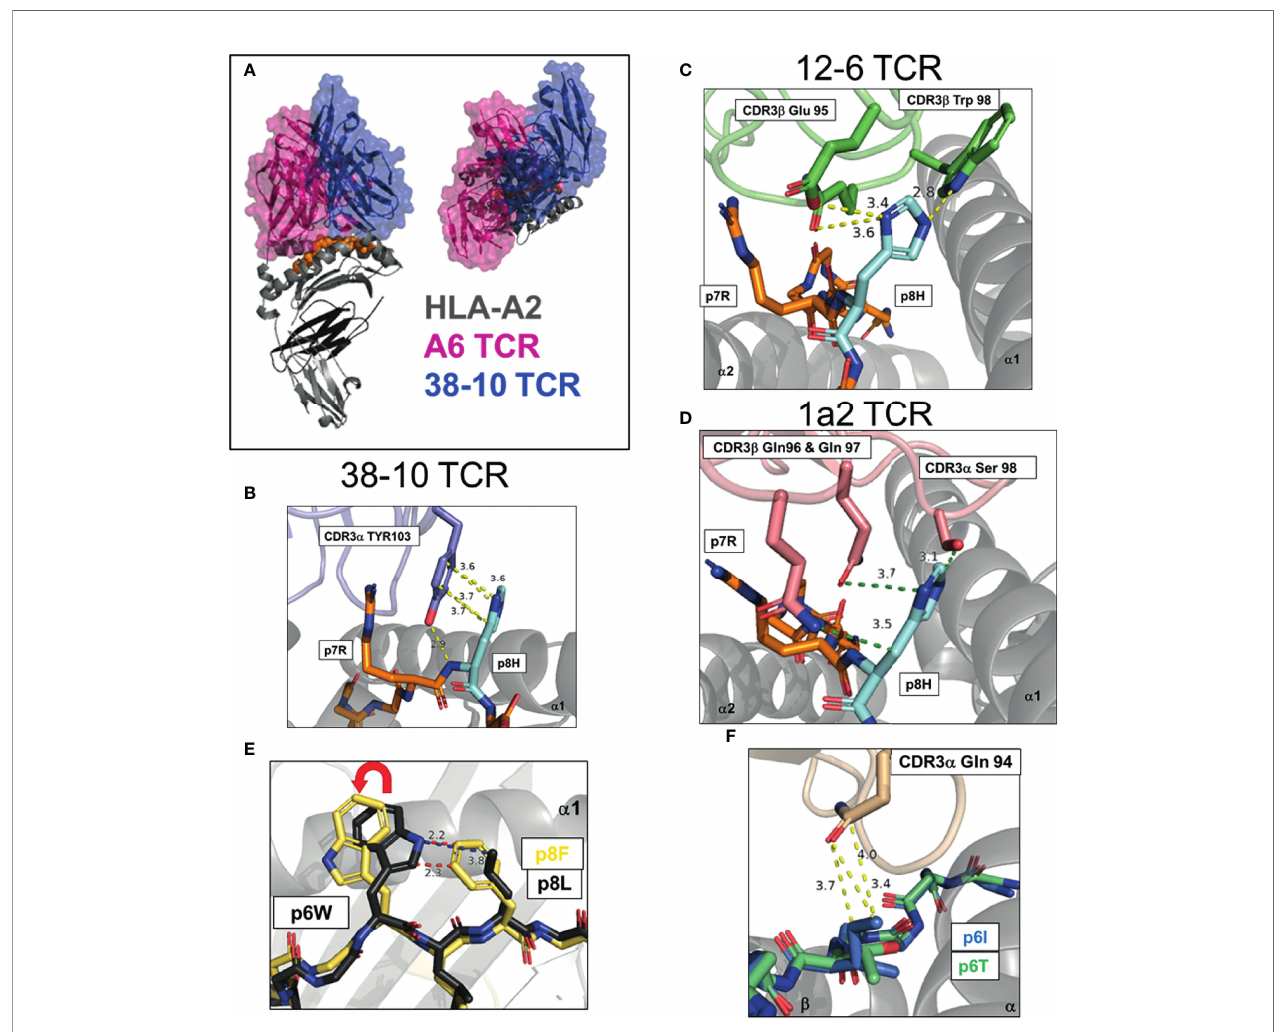
FIGURE 2 | Multiple strategies to detect mutated ‘ self ’ epitopes, group 1 neoantigens. (A) Docking of A6 TCR and 38-10 TCR on HLA-A2 displaying C-terminal shift of 38-10 TCR speci fi c for p53 R175H (PDB entry 1AO7, 6VRN). (B – D) Dominant TCR contacts with p8 of HMTEVVR H C, p53 R175H neoantigen presented by HLA-A2 by 38-10 TCR (6VRN) (B) , 12-6 TCR (6VRM) (C) and 1a2 TCR (6QVO) (D) . (E) Peptide pre-organization confers structural dissimilarity. Peptide p8 in HHAT L75F neoantigen KQWLVWL F L pre-organizes p6W into optimal TCR binding con fi rmation to allow effective tumor detection (6UK2,6UK4). (F) Direct recognition of exposed mutation. Mutant p6I in GELIG I LNAAKVPAD TPI neoantigen confers more TCR-E8 contacts that WT p6T (2IAM,